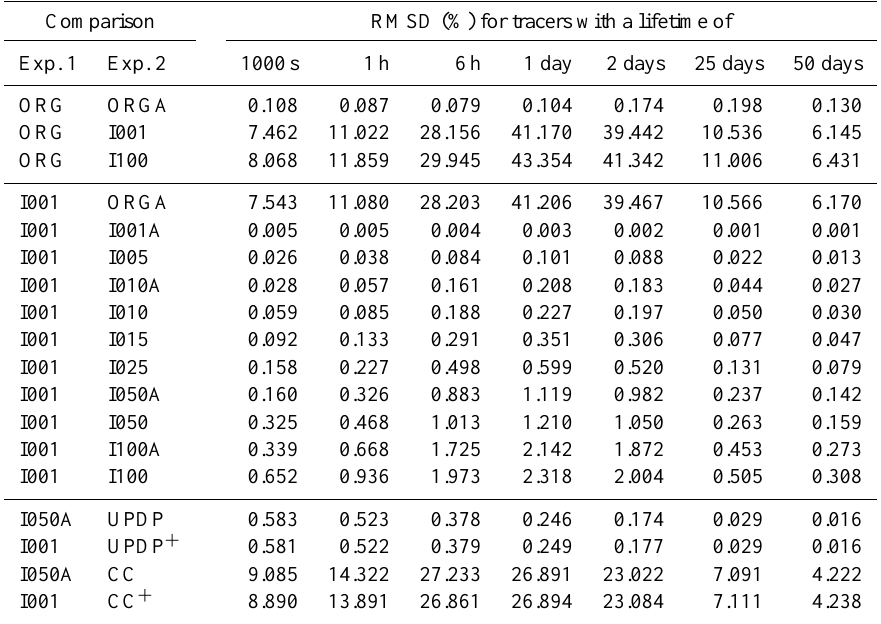
Table 3. Weighted root mean square deviations between two numerical experiments. Results, expressed as percentages of the respective air-mass-weighted mixing ratios, are listed for the seven